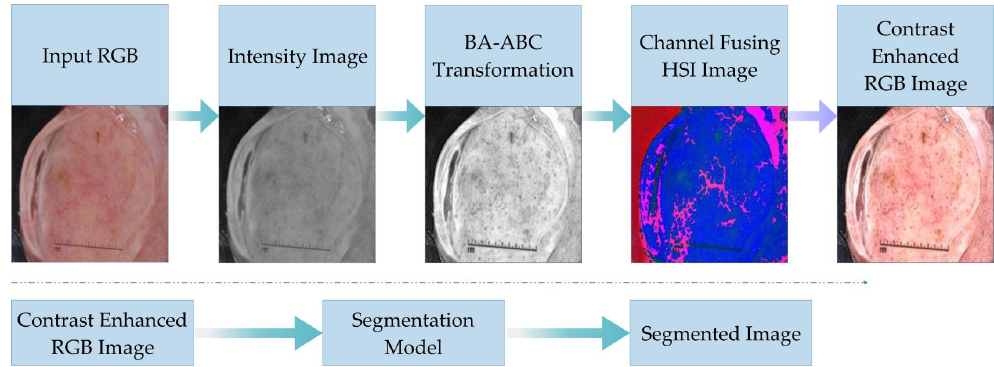
Figure 2. Flow of proposed algorithm.